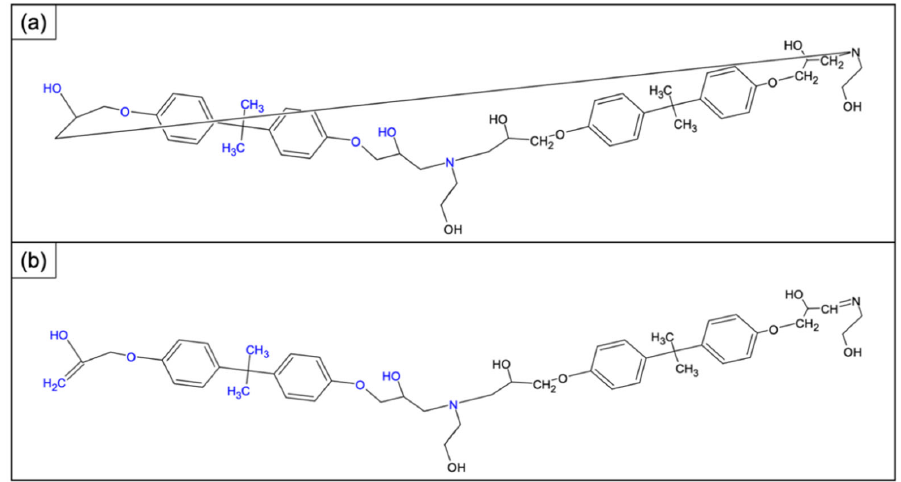
Figure 6. Dimeric structure with m/z 802 determined once the repetitive unit is known: hypothesized ( a ) cyclic structure and ( b ) linear structure with ending unsaturation points.